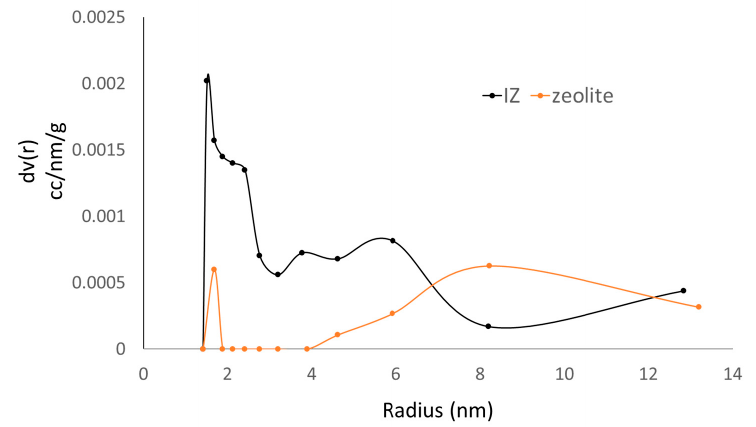
Figure 5. The BJH pore size distribution of zeolite and IZ.